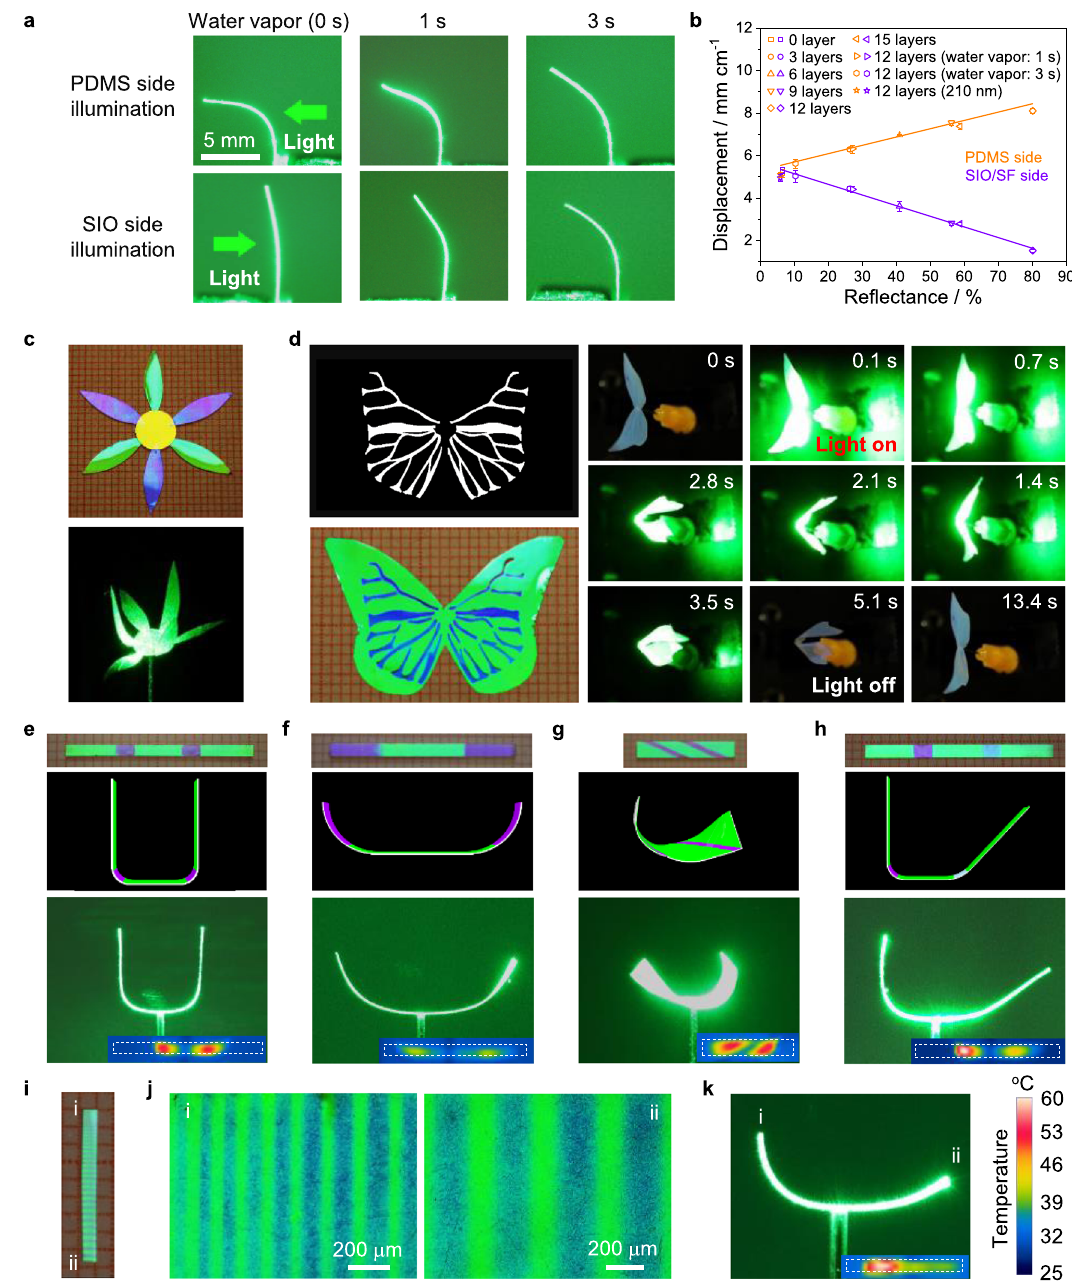
Fig. 3 Programmable motion via photonic nanostructure design. a Photographs showing the deformation of the same photonic actuator before and after water vapor treatment for different durations ( I = 35 m cm − 2 ). b Dependence of displacement on the re fl ectance intensity of the SIOs at 532 nm ( I = 35 m cm − 2 ). c Photographs of a fl ower-shaped geometry (top) and relative selective bending of the photonic bilayer structure after light irradiation (bottom). d (Left) Stencil design used to produce a pattern on a butter fl y-shaped photonic bilayer (top) and the corresponding photograph (bottom). The pattern was generated by exposing masked SIO to water vapor for 3 s. (Right) The actuation process of the butter fl y under laser illumination from PDMS side (Input power: 0.5 W). e – h (Top) Photographs of patterned bilayer strips by water vapor exposure ( e – g and h -left: 3 s, h -right: 1 s). The width of patterns is: 2 mm in e and h , 5 mm in f , and 1 mm in g . (Middle and bottom) Schematics and images of the corresponding motion modes under laser illumination from SIO side: symmetrical folding ( e ), outer bending ( f ), twisting ( g ), and unsymmetrical folding ( h ). i Photograph of a bilayer strip with microscale lines. The line width changes gradually from one side to another. j Optical microscopy images showing the lines near the two margin areas of the strip. k Corresponding motion mode upon exposure to laser source. The insets in e – h and k show the infrared images of the patterned strips under laser irradiation with dashed line outlining the edge of the sample before laser irradiation. Error bars denote the standard deviation of the measurements ( n =